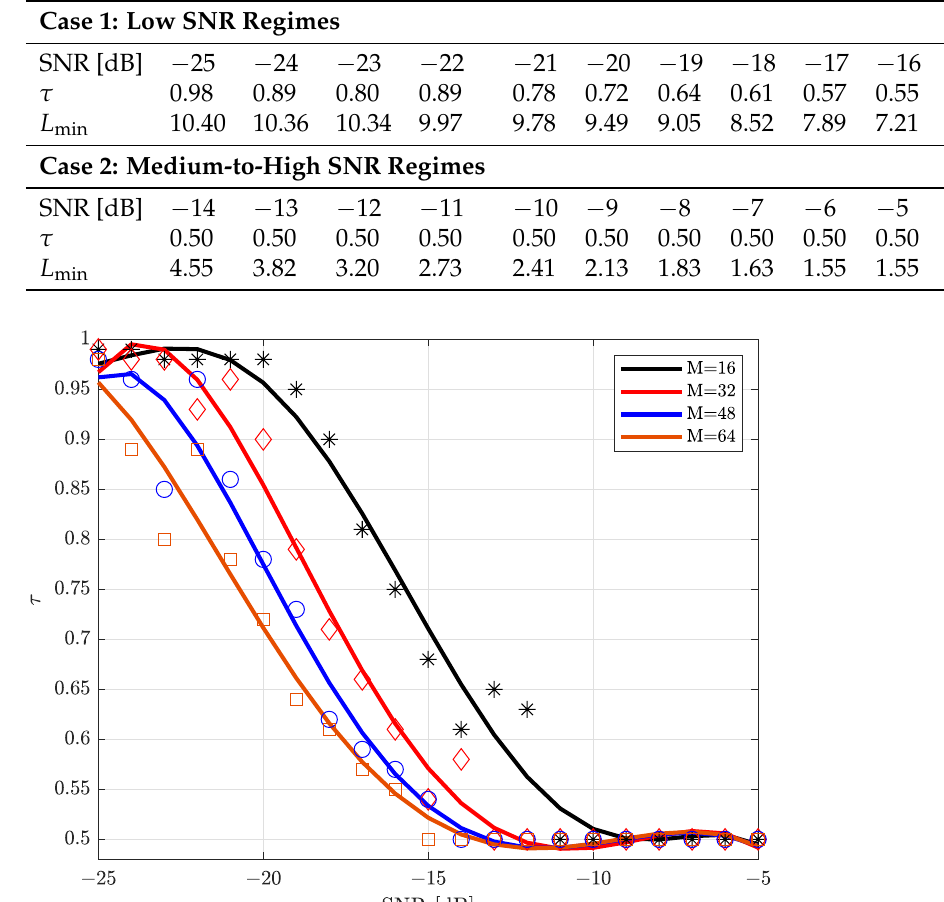
Figure 2. A demonstration for quantization threshold, τ , and detection repetitions, L , versus SNR [dB] with M = 64. Table 1. The results of the Monte Carlo simulation for different SNRs.